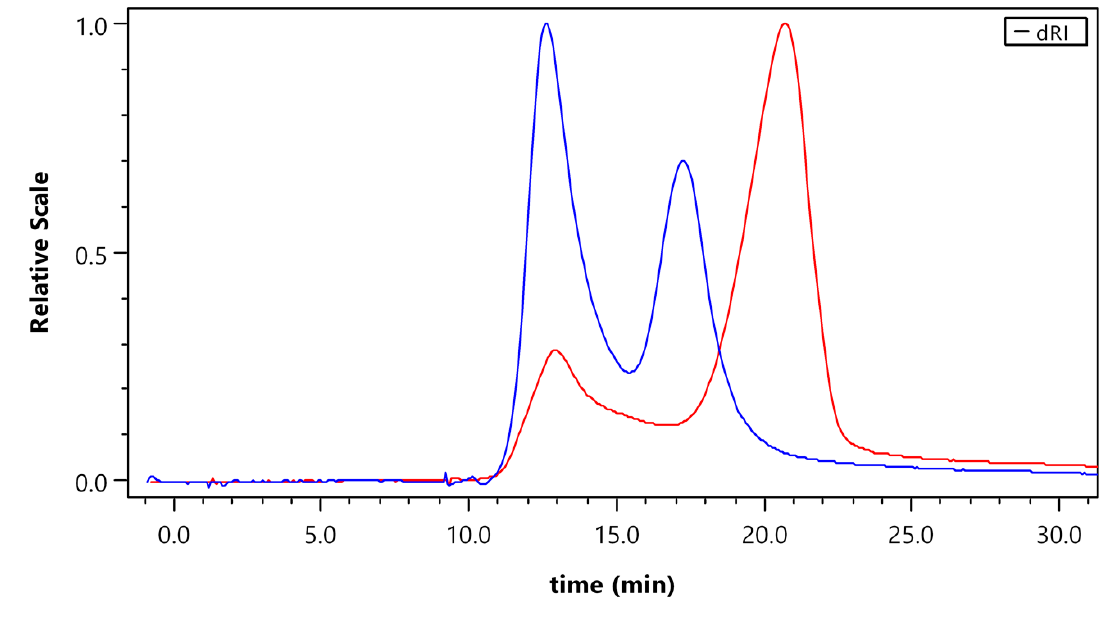
Figure 2. Chromatograms of molar weights of diblock P4 (red curve) and triblock P6 (blue curve) copolymers determined by FFF (3 mg mL − 1 ; mobile phase: water / NaN 3 ; 10 kDa regenerated cellulose).